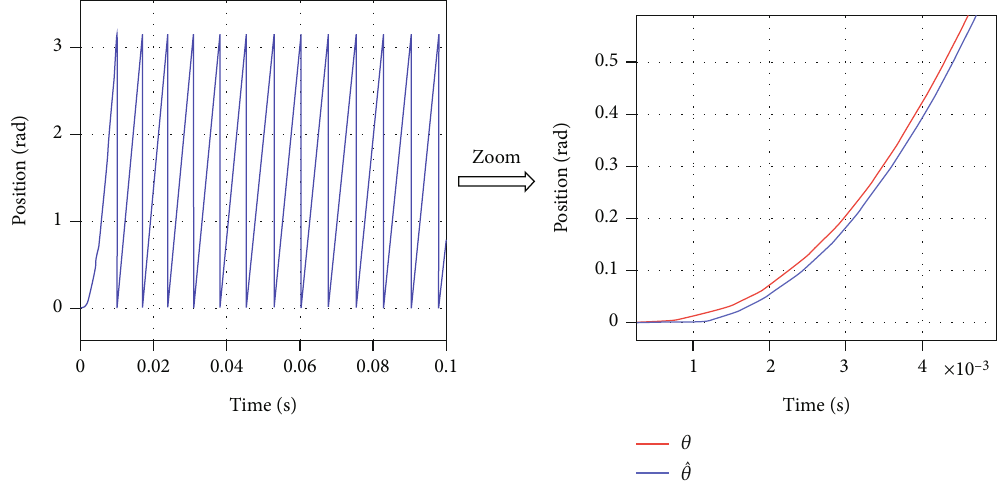
Figure 15: Results of estimated position using the